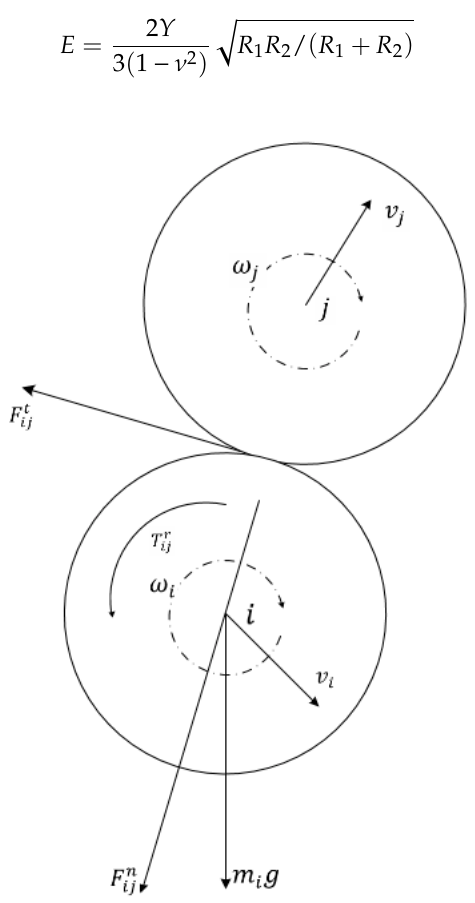
Figure 4. Schematic illustration of the forces acting on powder i in contact with powder j.